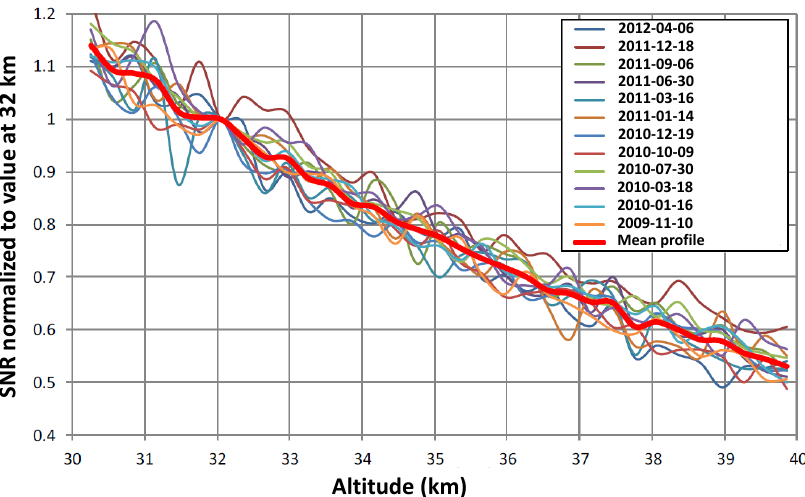
Figure 3. Twelve SNR profiles from CALIOP measurements, calculated between 30km and the maximum CALIOP measurement altitude of 40km, and representing various latitudes and seasons. The thick red line is the mean profile.